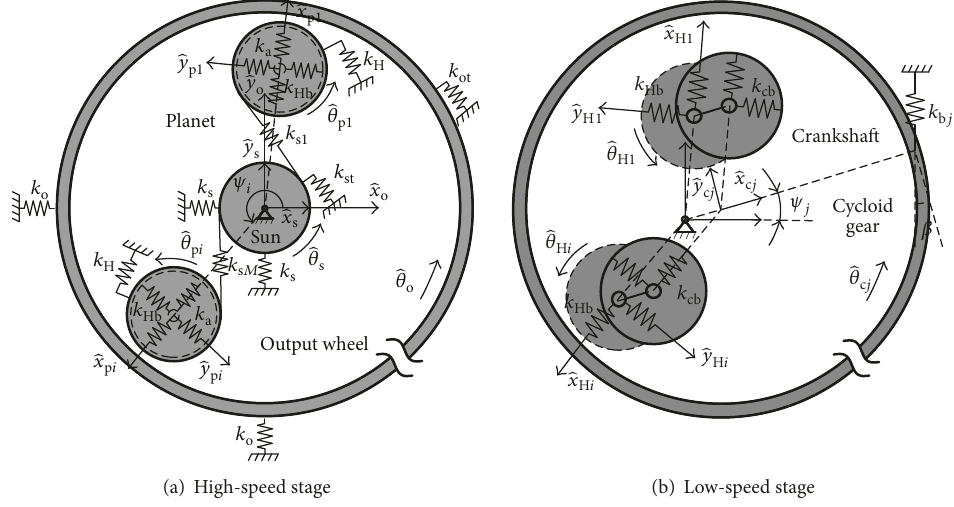
Figure 2: Lumped parameter model of RV reducer and